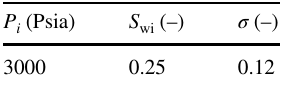
Table 4 Initial conditions of